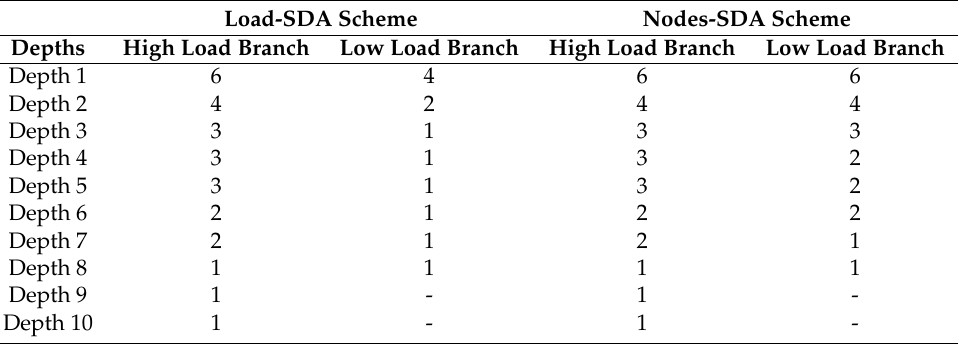
Table 8. Average Superframe Order values (per depth) for both the high load and low load zones (conditioned